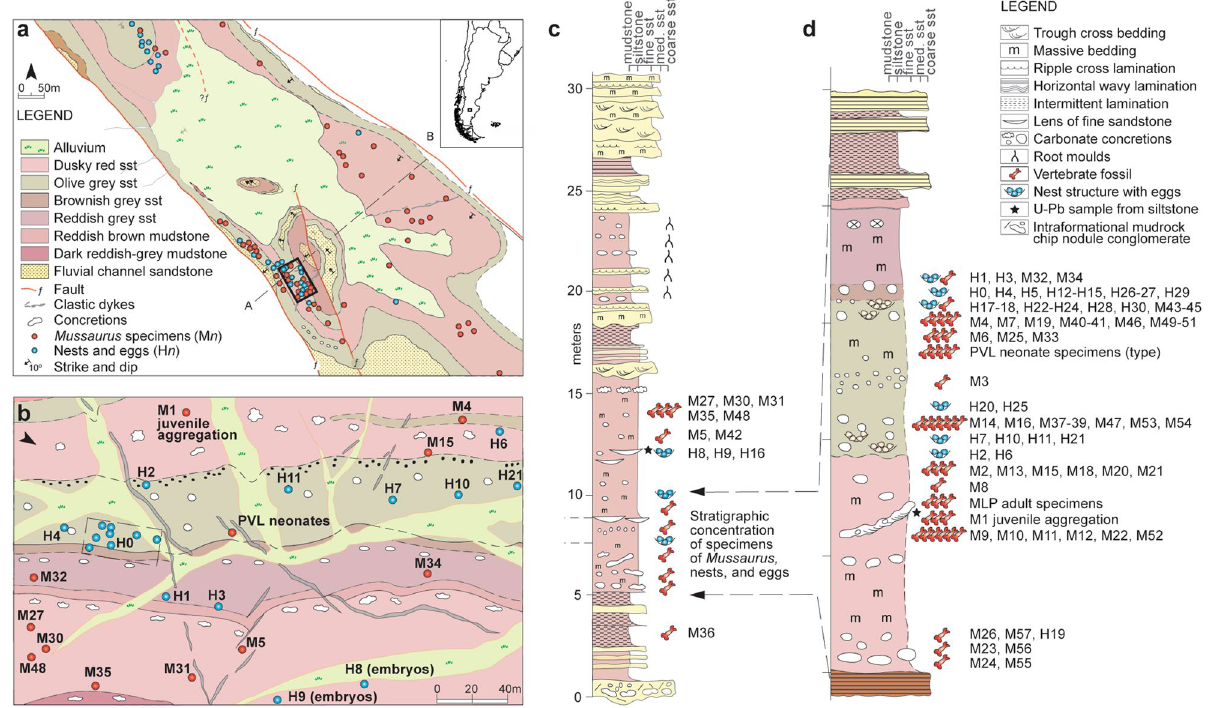
Figure 1. Locality map and stratigraphic section of the Laguna Colorada type locality. ( a ) general map of fossil findings at the locality (red dots represent skeletal remains of M. patagonicus and blue dots represents eggs or nests, cross section A–B is provided in the Supplementary Information); ( b ) detailed map of area with high fossil density (including associated juveniles, neonates, and nests), location of this area is indicated with a black rectangle in general map. Refer to Supplementary Information Fig. 2 showing the structural dip of strata approximately 15 degrees southwest. Arrow in maps indicates north; ( c ) general stratigraphic section of the type locality showing the position of skeletal remains and eggs/nests of M. patagonicus ; ( d ) detailed stratigraphic section of the 3 m-thick interval with the highest concentration of Mussaurus skeletons and